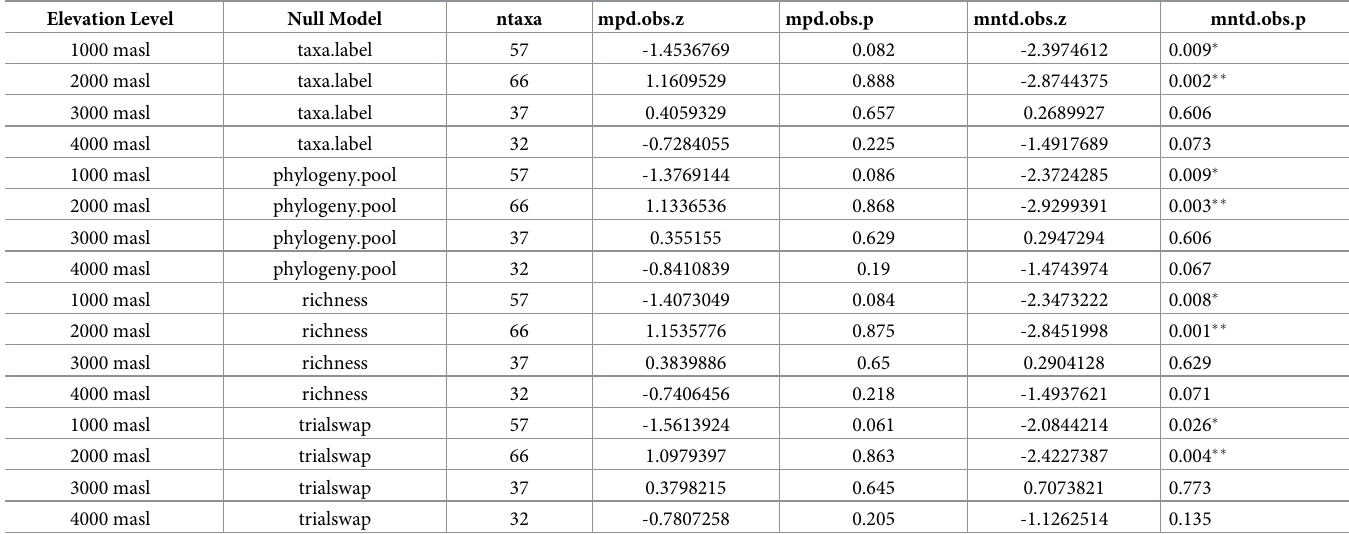
Phylogenetic community analyses results for each elevation level show significantly negative MNTD values for the 1000/2000 masl elevation levels only. Significantly negative MPD and MNTD values indicate phyogenetic clustering. mpd.obs.z: effect size for mean phylogenetic distance; mpd.obs.p: p-value for MPD; mntd.obs.z: effect size for mean nearest taxon distance; mntd.obs.p: p-value for MNTD � = p.value < 0.05